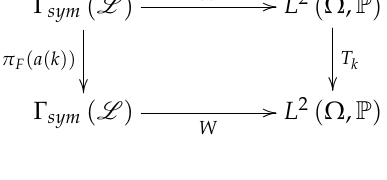
Figure 2. The first operator.